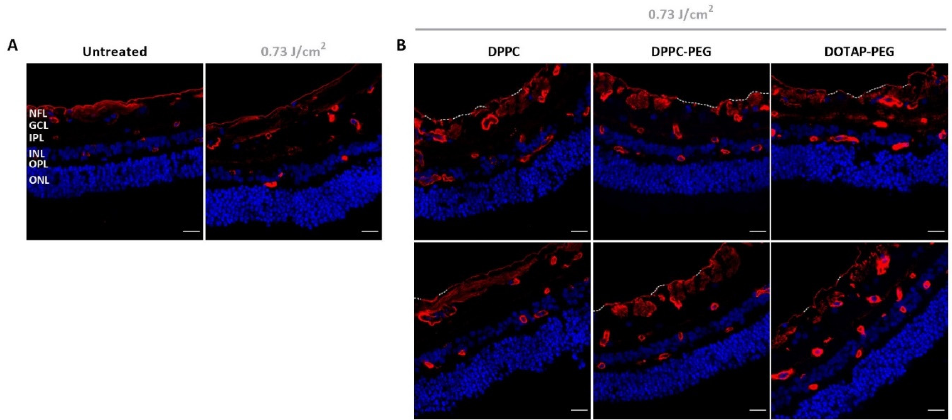
Figure 6. Visualization of retinal cryosections via confocal microscopy. ( A ) Control samples: untreated and laser treated. ( B ) Treated samples: application of ICG liposomes on top of bovine retinal explants followed by laser treatment with 800 nm pulsed laser light. Blue: Hoechst staining to visualize nuclei. Red: immunostaining for Collagen IV to show the ILM and blood vessels. White dotted line indicates complete absence of the ILM. Scale bar = 20 µ